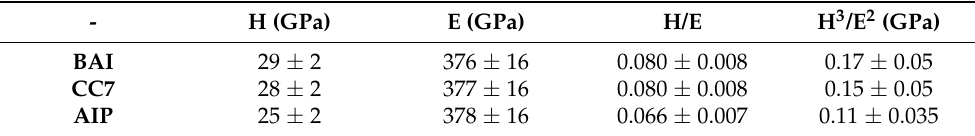
Table 3. Hardness (HV0.05), elastic modulus (E), H/E ratio and H 3 /E 2 ratio of TiN coatings deposited in BAI, CC7 and AIP deposition